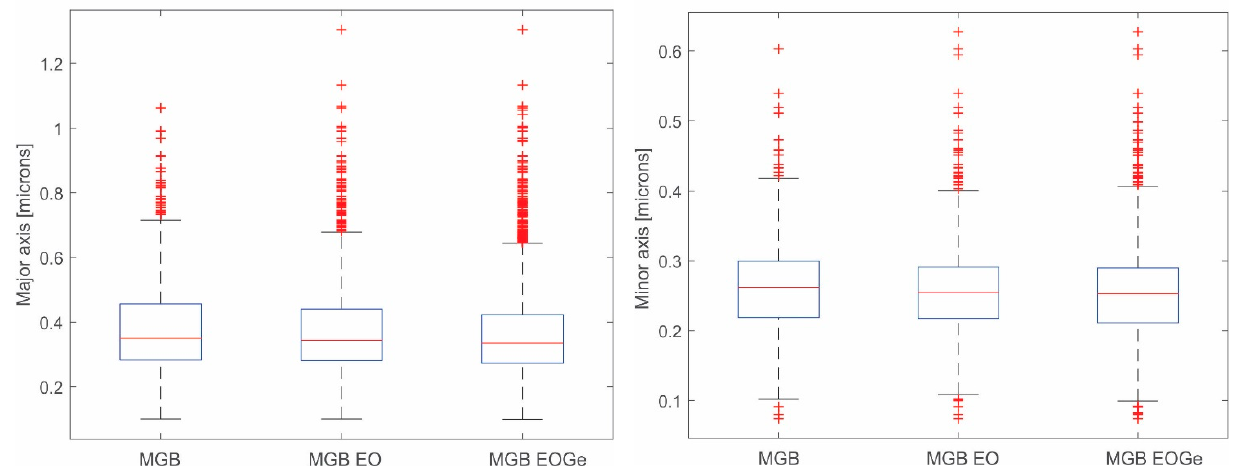
Figure 3. Box-plots of the size distribution of the MBG, MBG EO and MBG EOGe particles. Right, minor diameter; left, major diameter.